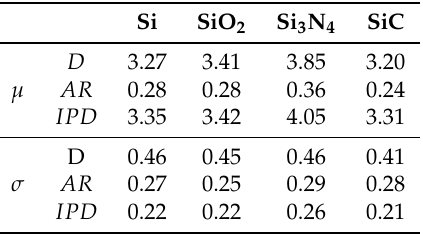
Table 1. Curve fitting parameters for lognormal distributions of AuNI diameters ( D ), aspect ratios ( AR ) and inter-particle distances ( IPD ) on various silicon